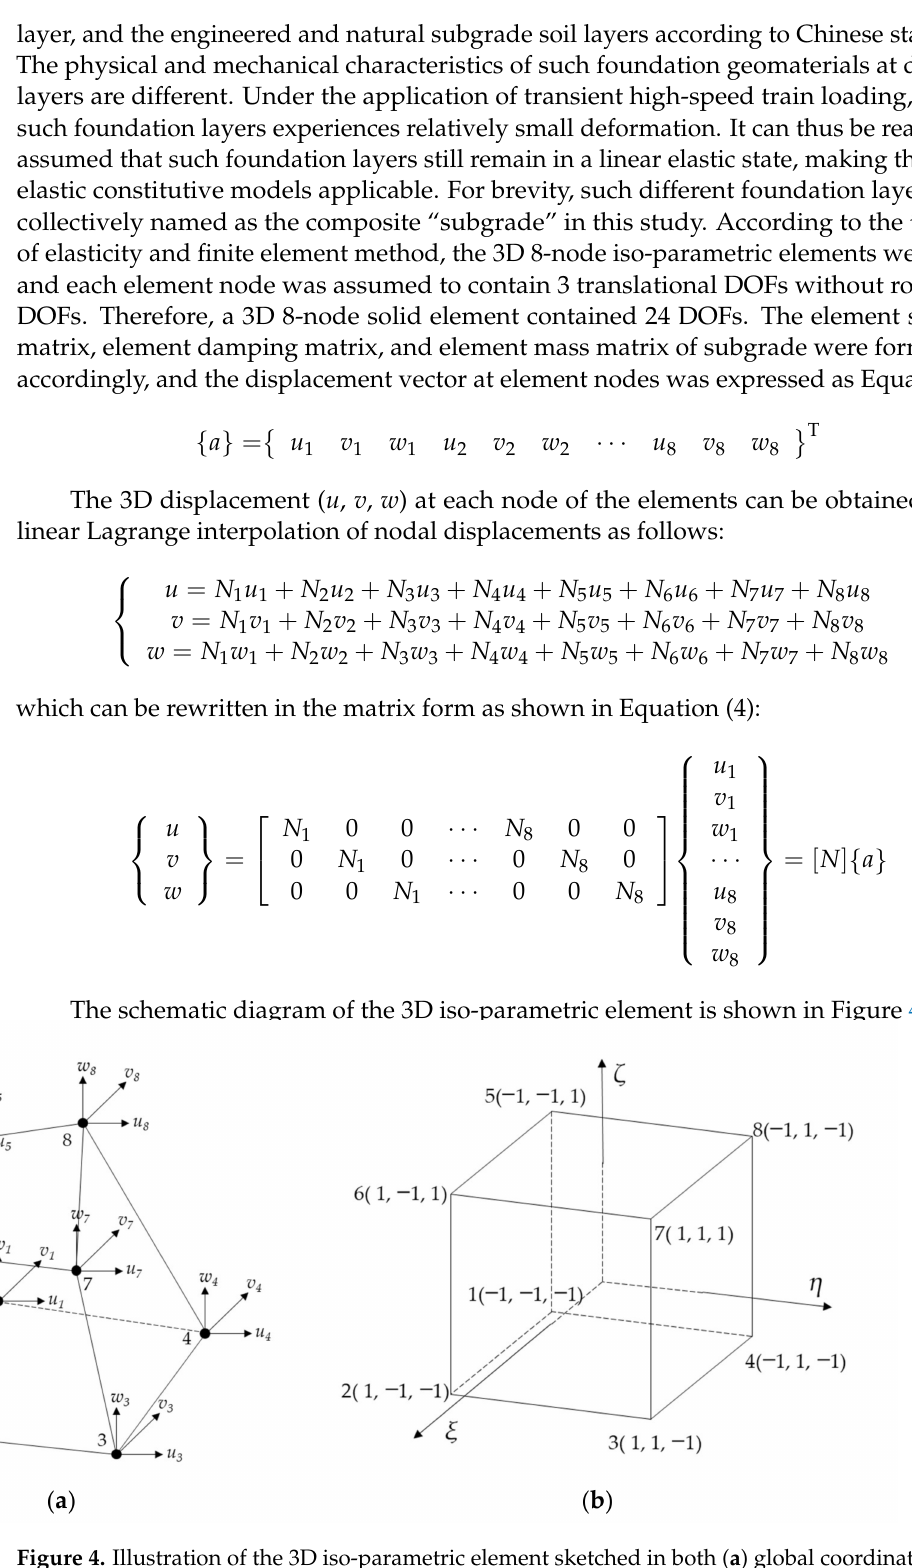
Figure 4. Illustration of the 3D iso-parametric element sketched in both ( a ) global coordinate system and ( b ) local coordinate